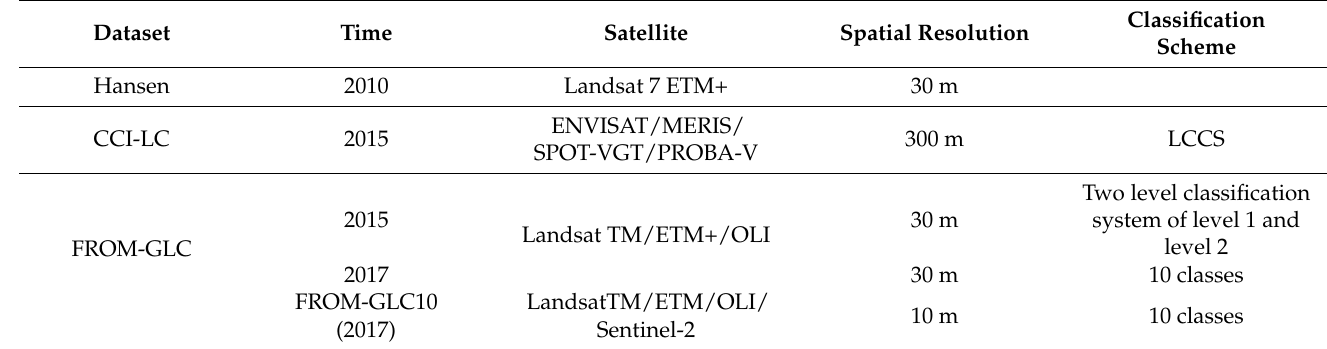
Table 1. Summary of the main characteristics of global land cover